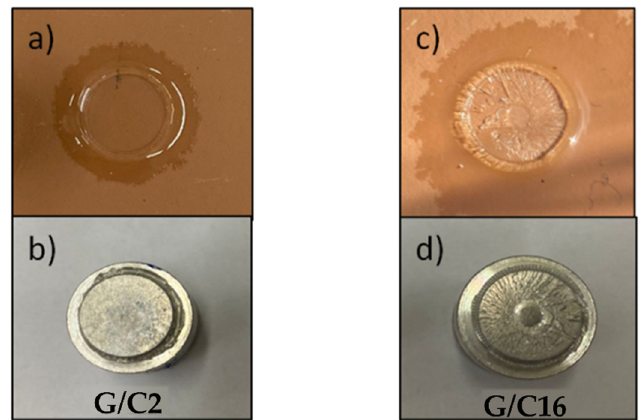
Figure 10. Substrates images and dollies after the pull off test, with adhesive properties sample ( a , b ) and cohesive properties ( c , d ) of G/C2 and G/C16 sample, respectively.